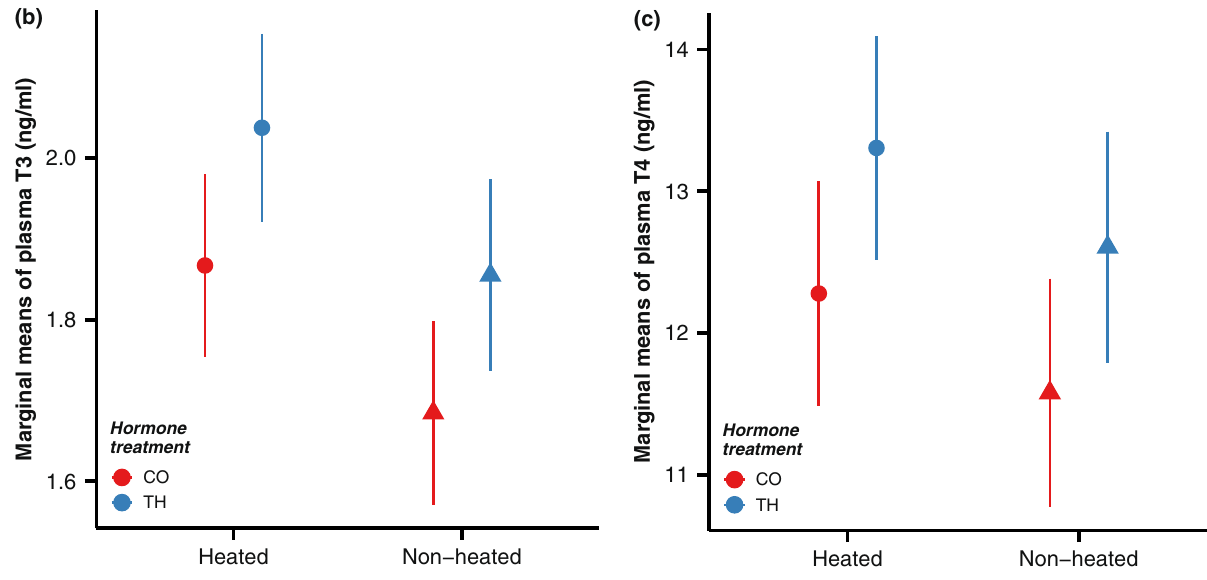
Figure 1. A correct version of the original Figure 2b-c. Effects of prenatal hormone manipulation (TH = experimentally elevated yolk thyroid hormone treatment, CO = control) and postnatal temperature manipulation (non-heated vs. heated nests) on offspring phenotype and physiology. ( a ) Nestling body mass growth pattern (g, average ± SE); ( b ) plasma triiodothyronine (T3) concentration (ng/ml, marginal means ± SE), ( c ) plasma thyroxine (T4) concentration (ng/ml, marginal means ± SE), ( d ) mitochondrial density in blood cells (ln-transformed, marginal means ± SE), ( e ) blood total glutathione concentration (tGSH, nmol/mg protein, ln-transformed means ± SE) and ( f ) lipid peroxidation (MDA concentration, µmol/mg protein, ln-transformed means ± SE). Heated nests were on average 2.75 °C warmer than non-heated ones. See text and ESM for details on statistics and sample